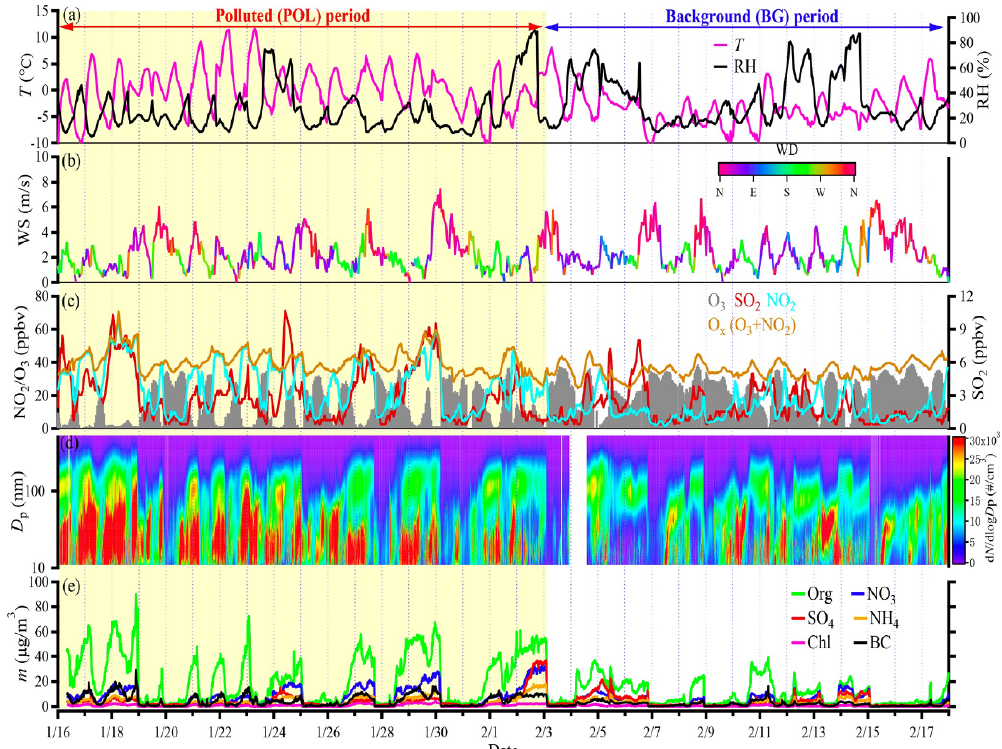
Figure 9. Time series of meteorology and aerosol precursor gases and species before (polluted) and during (background) the 2019 Chinese Spring Festival (16 January to 17 February 2019) in Beijing, China. (a) Ambient temperature ( T ) and relative humidity (RH), (b) wind direction (WD) and speed (WS), (c) volume mixing ratios of trace gases [O 3 , SO 2 , NO 2 , and O x (O 3 + NO 2 )], (d) the aerosol particle number size distribution measured by the SMPS, and (e) mass concentrations of aerosol chemical species in PM 2 . 5 measured by the ACSM and the AE-33. (adapted from Wang et al.,